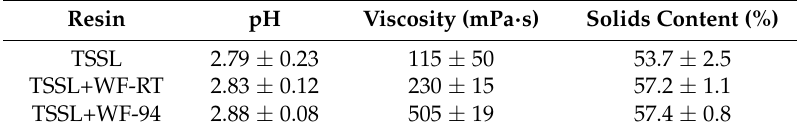
Table 1. Final Properties of the thick spent sulfite liquor (TSSL) and TSSL+WF (wheat flour) Resin